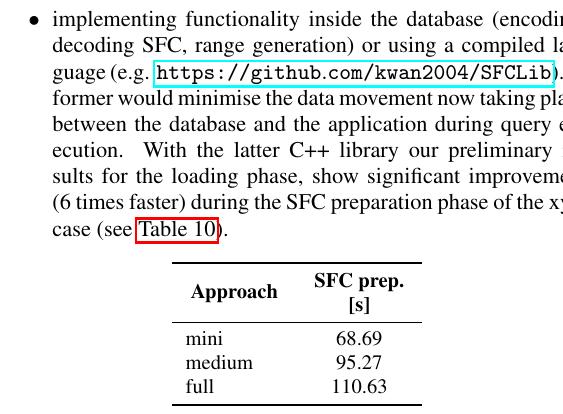
Table 10: Using C++ code for the SFC transformation • investigating parallel processing in all of the steps. • using even more massive point cloud data for executing bench-